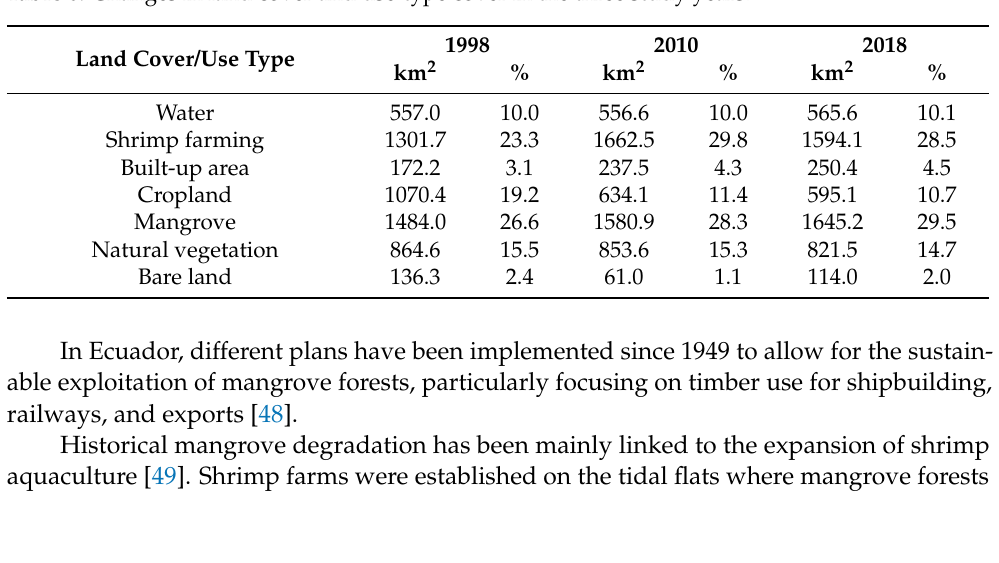
vegetation (V), and bare land (BL).